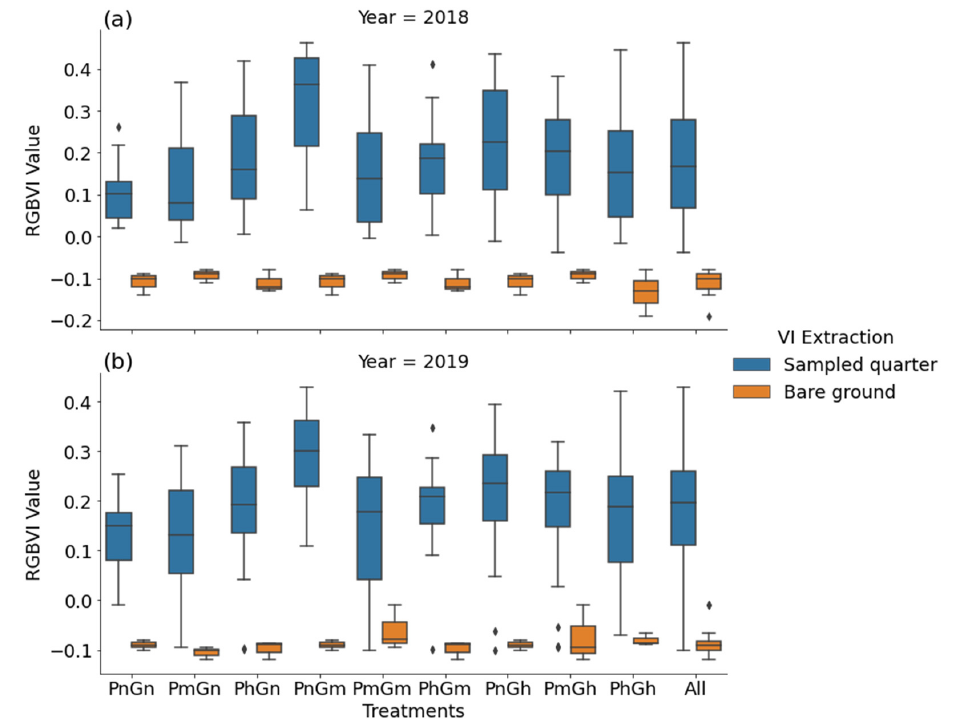
Figure 5. RGBVI value of sampled quarter and extracted bare ground: ( a ) the year of 2018; ( b ) the year of 2019.